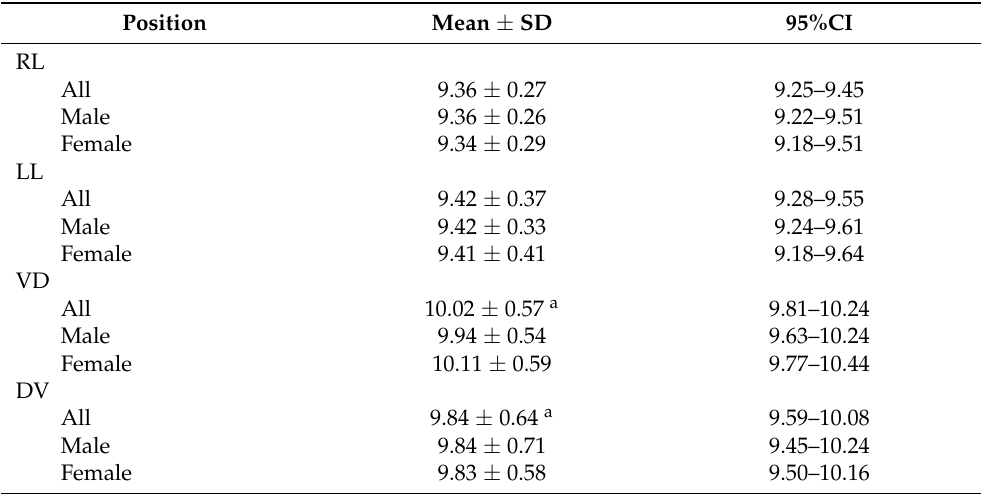
Table 3. Vertebral heart scores of Corgis on all radiographic positions of right lateral (RL), left lateral (LL), ventrodorsal (VD), and dorsoventral (DV) projections.